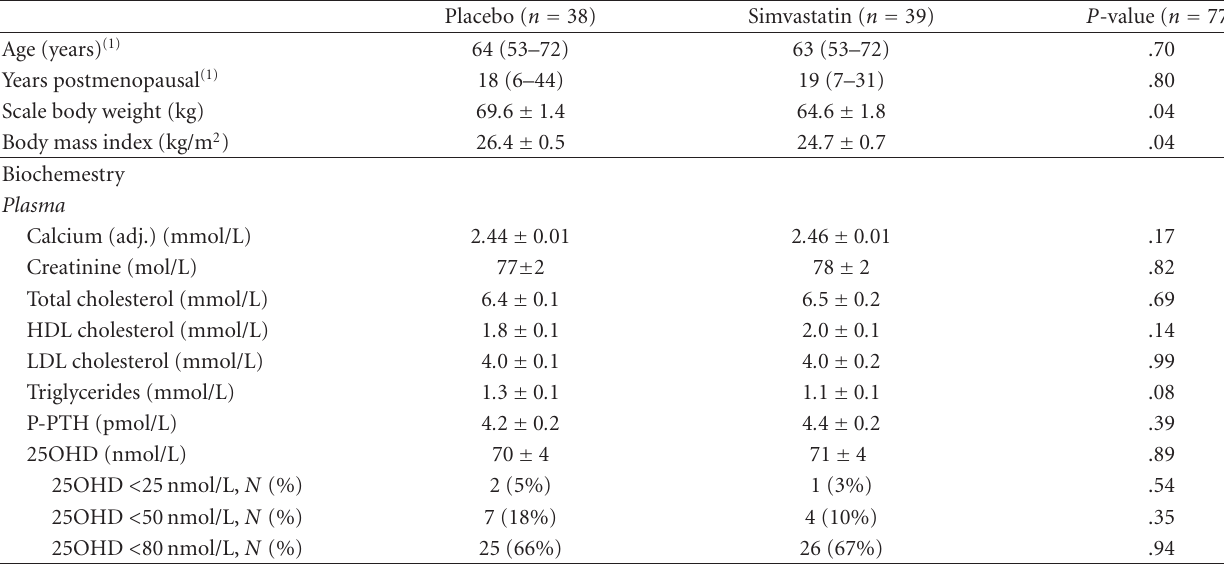
Table 1: Baseline characteristics by study group (mean ± sem).